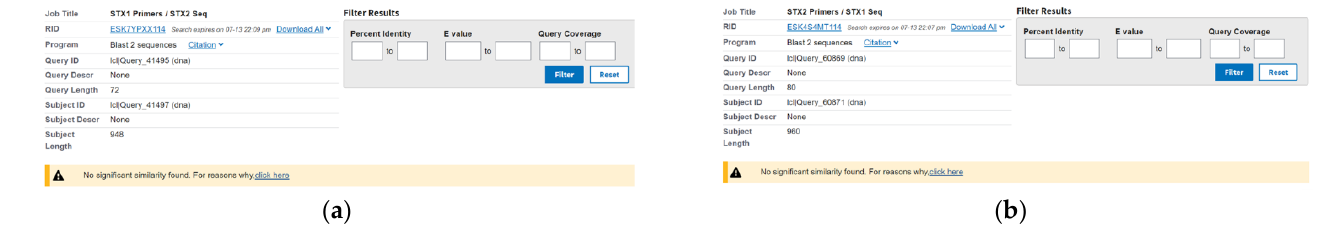
Figure 4. Primer sets were compared to their opposing toxin for cross-reactivity. ( a ) Shiga toxin 1 primers blasted against the sequence for Shiga toxin 2. ( b ) Shiga toxin 2 primers blasted against the sequence for Shiga toxin 1. These results were obtained by searching for highly similar sequences (megablast.) Results were obtained from https://blast.ncbi.nlm.nih.gov/Blast.cgi (accessed on 14 July 2021).